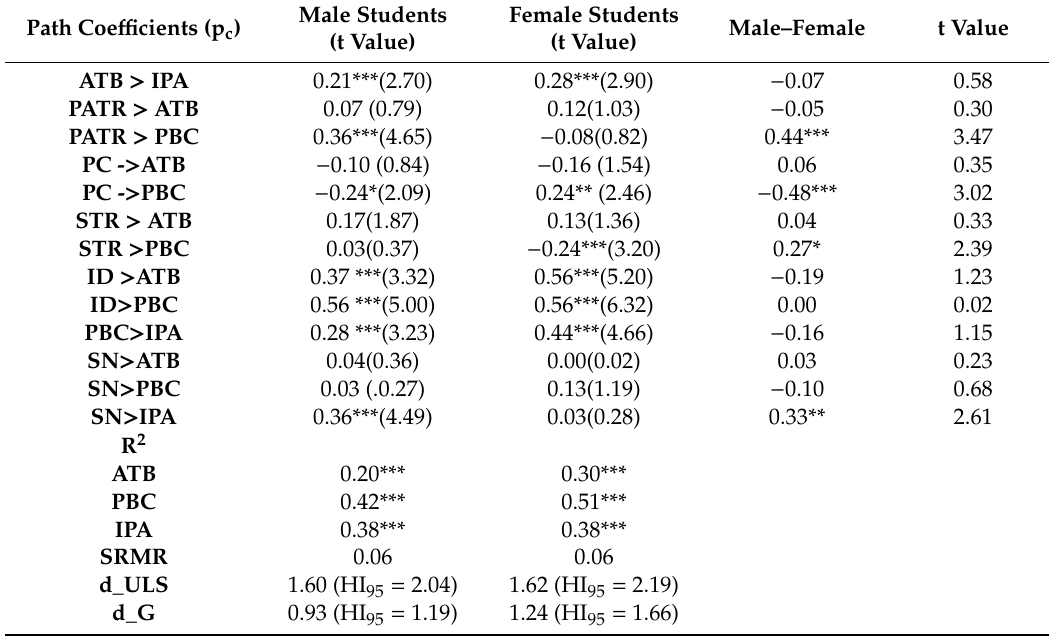
Table 5. Multi-group analysis of the model to predict the intention to be physically active after graduation according to the gender: path coe ffi cients, R 2 , and fit indexes of the